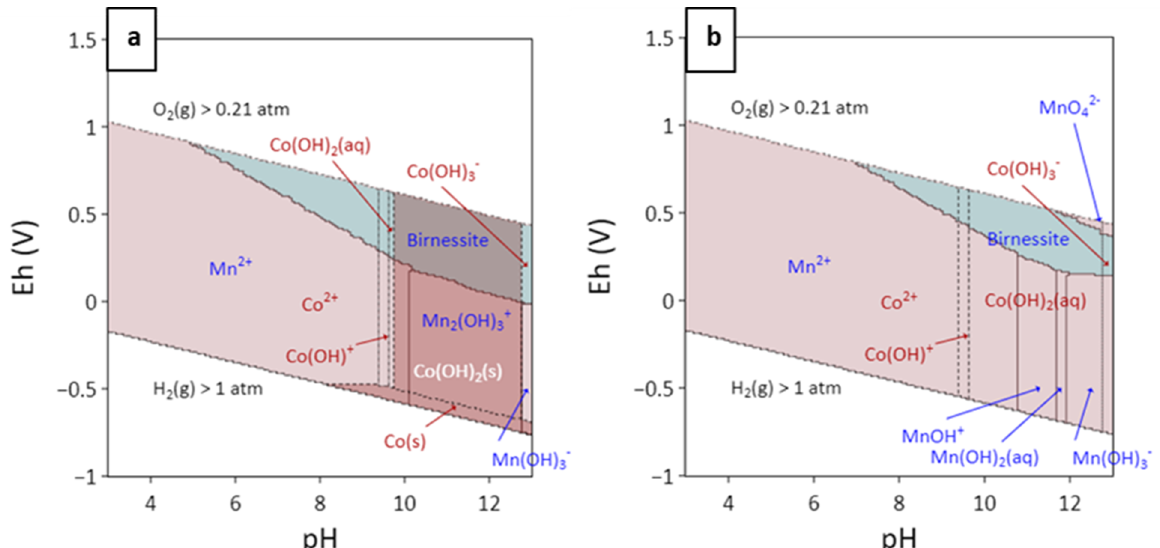
Figure 14. Predominance diagram (Eh–pH) of the Mn–Co–H 2 O system calculated with Gibbs Studio [30] and the llnl.dat database from [31] with some modifications (see text for explanation), at 25 °C, with a total aqueous concentration of Mn and Co of 10 − 6 M ( a ) and 10 − 10 M ( b ).